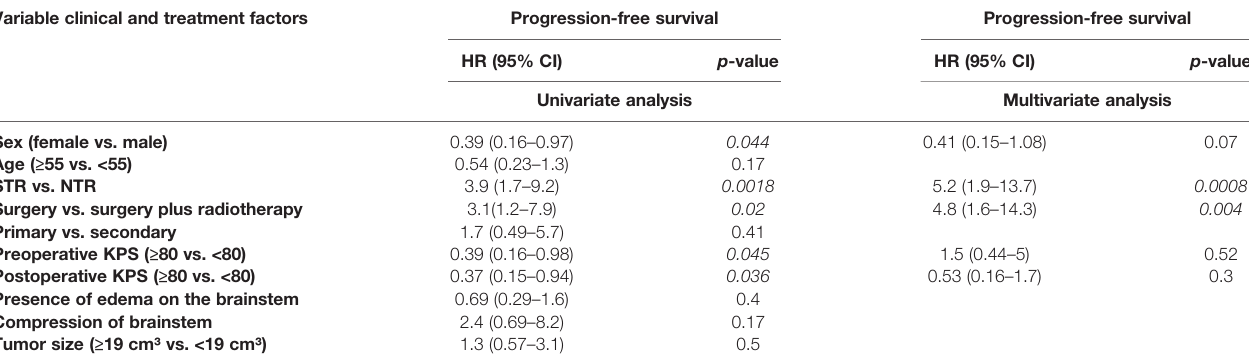
TABLE 3 | Cox-regression analysis of patient with in fi ltration of cavernous sinus. Variable clinical and treatment factors